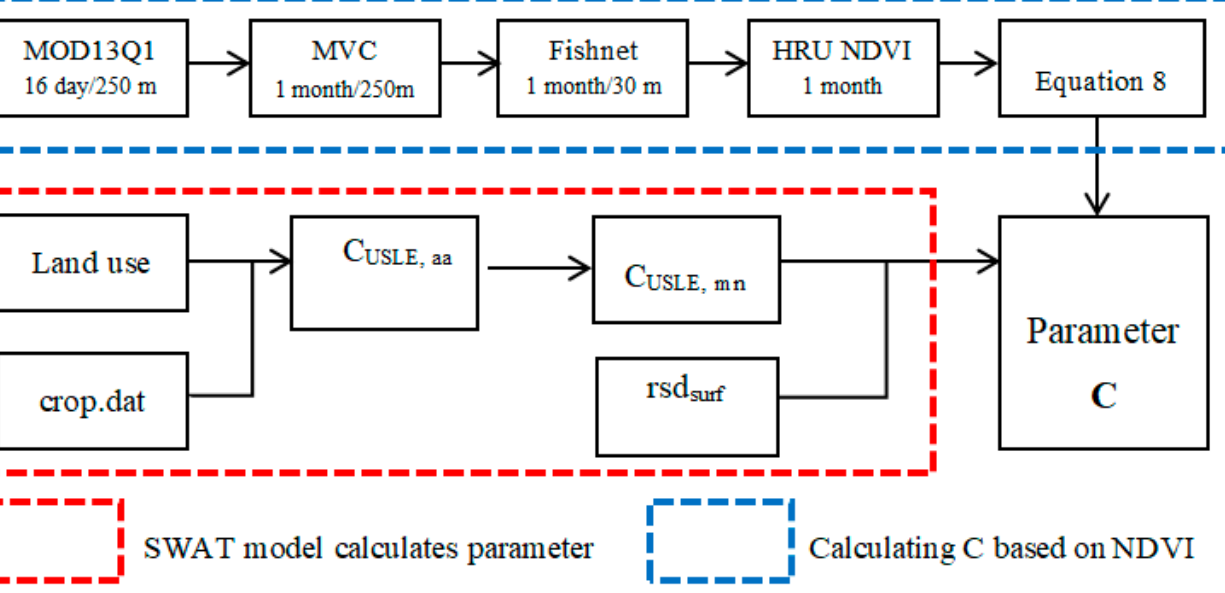
Figure 2. Flowchart of C USLE modification in the SWAT model based on NDVI data.